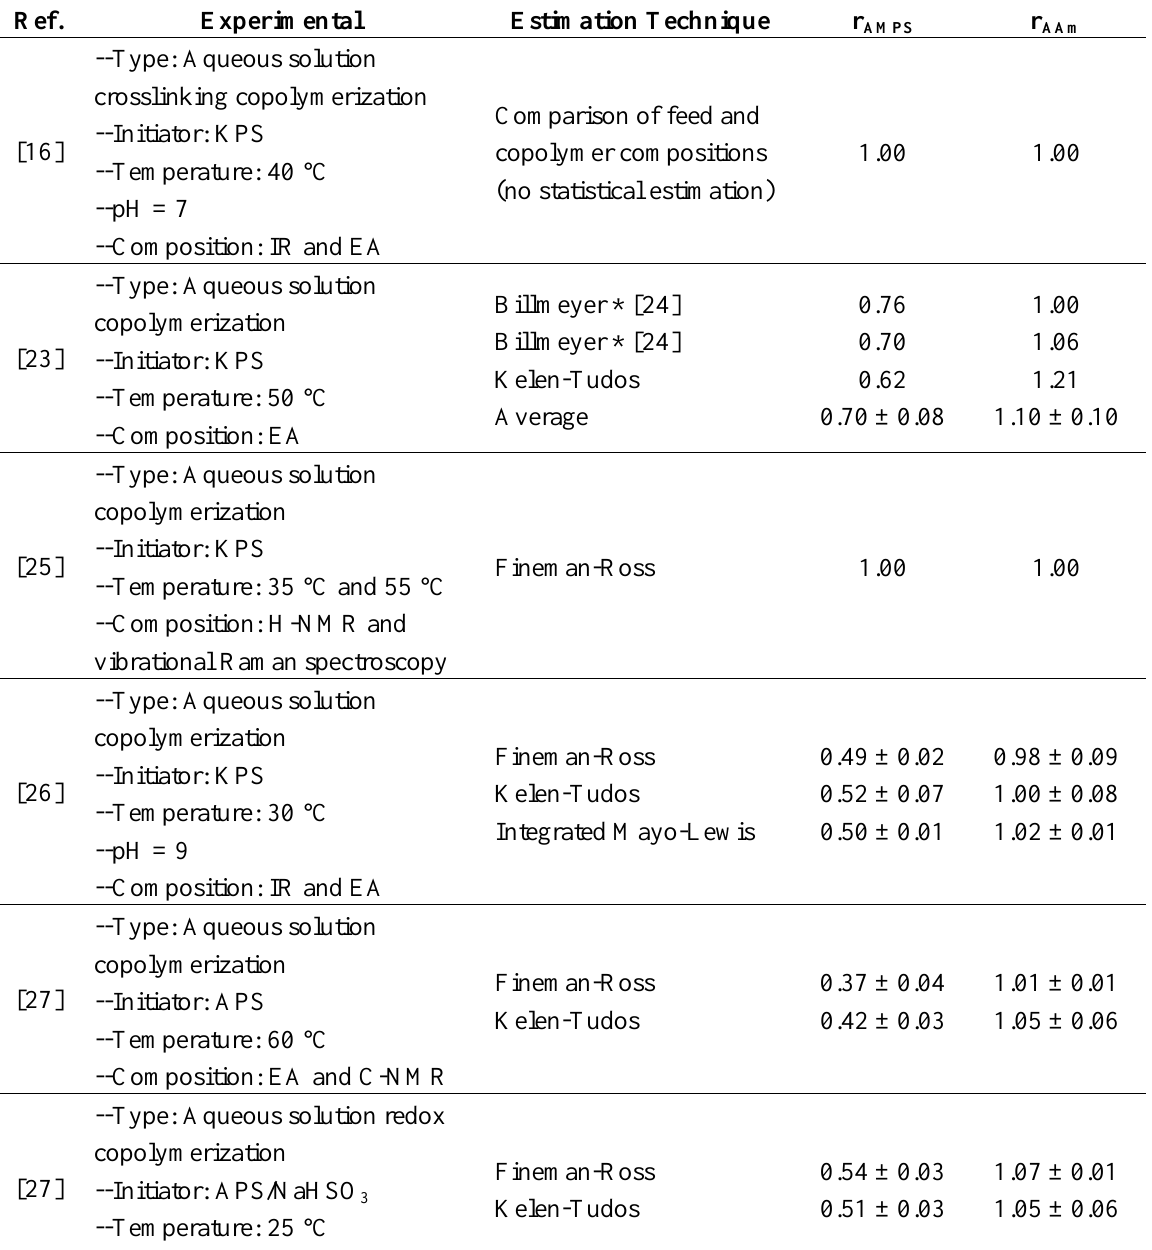
Table 1. Reactivity ratio summary for